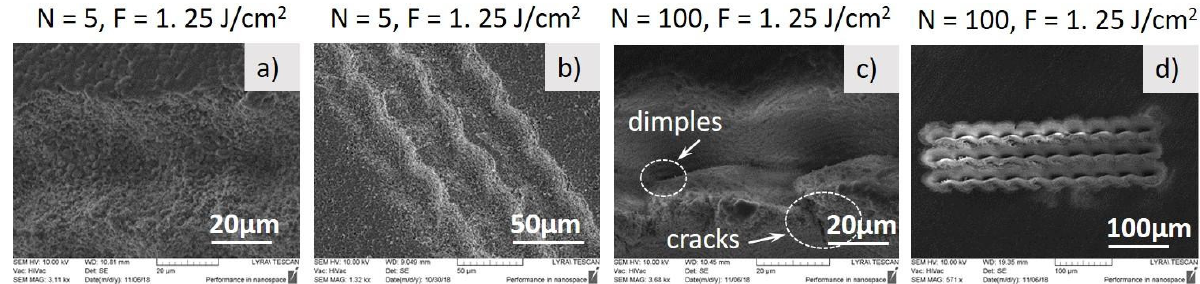
Figure 2. Scanning electron microscopy (SEM) images ( a – g ) and table of energy—dispersive X-ray spectroscopy (EDX) Figure 3. SEM images of surface-modified β -TCP pellets in the form of microchannels formed after laser irradiation in results, showing element concentration [wt.%] of β -tricalcium phosphate ( β -TCP) pellets, as follows (from left to right): spot-to-spot scanning regime with fs-laser pulses for the following: N = 5 ( a , b ) and 100 ( c , d ); F = 1.25 J/cm 2 , λ = 800 nm, τ untreated surface (control) and treated with N = 1, 10, and 100 pulses; F = 0.8 J/ cm 2 ; λ = 800 nm; τ = 130 fs. = 130 fs.